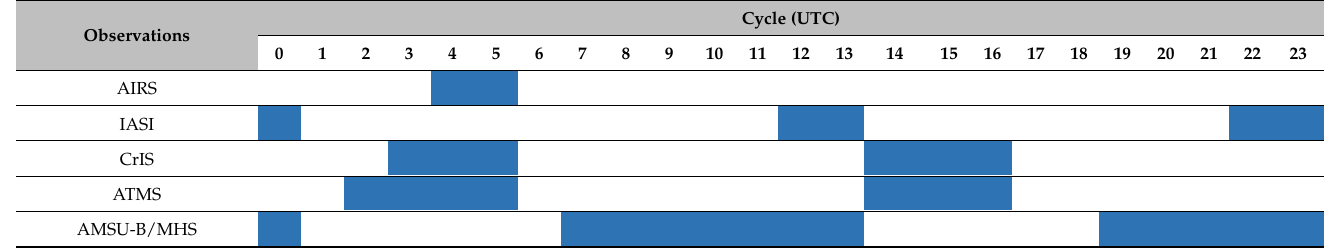
Table 2. Typical daily data availability per cycle over the SY domain in